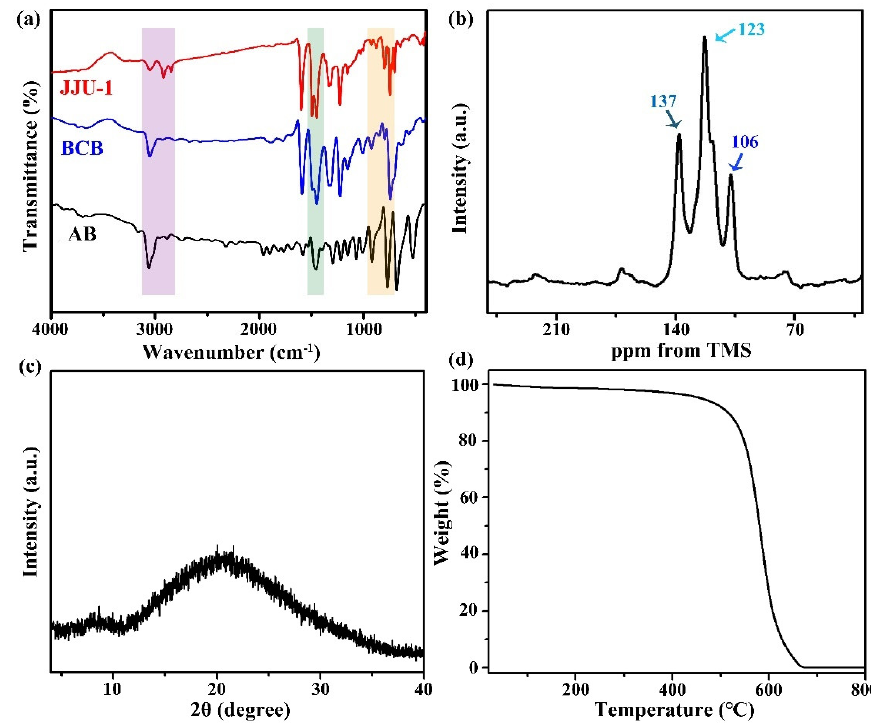
Figure 1. ( a ) FT-IR spectra of AB (black), BCB (blue) and JJU-1 (red); ( b ) the 13 C solid-state NMR spectrum; ( c ) PXRD and ( d ) TGA curve of JJU-1.